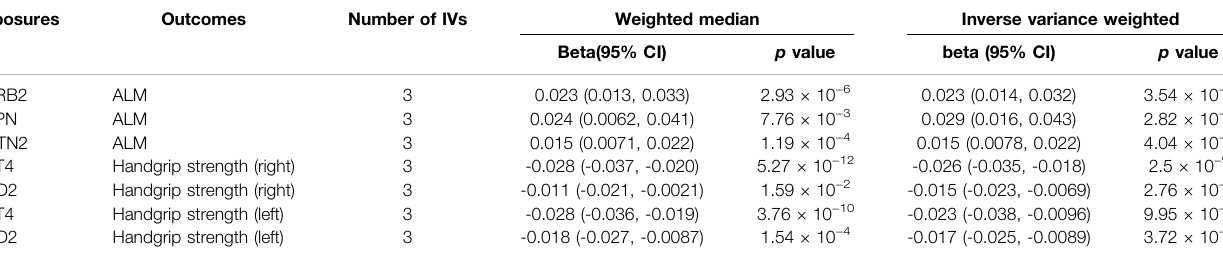
TABLE 6 | Association between plasma proteins and sarcopenia-related traits using Weighted median and Inverse variance weighted. Exposures